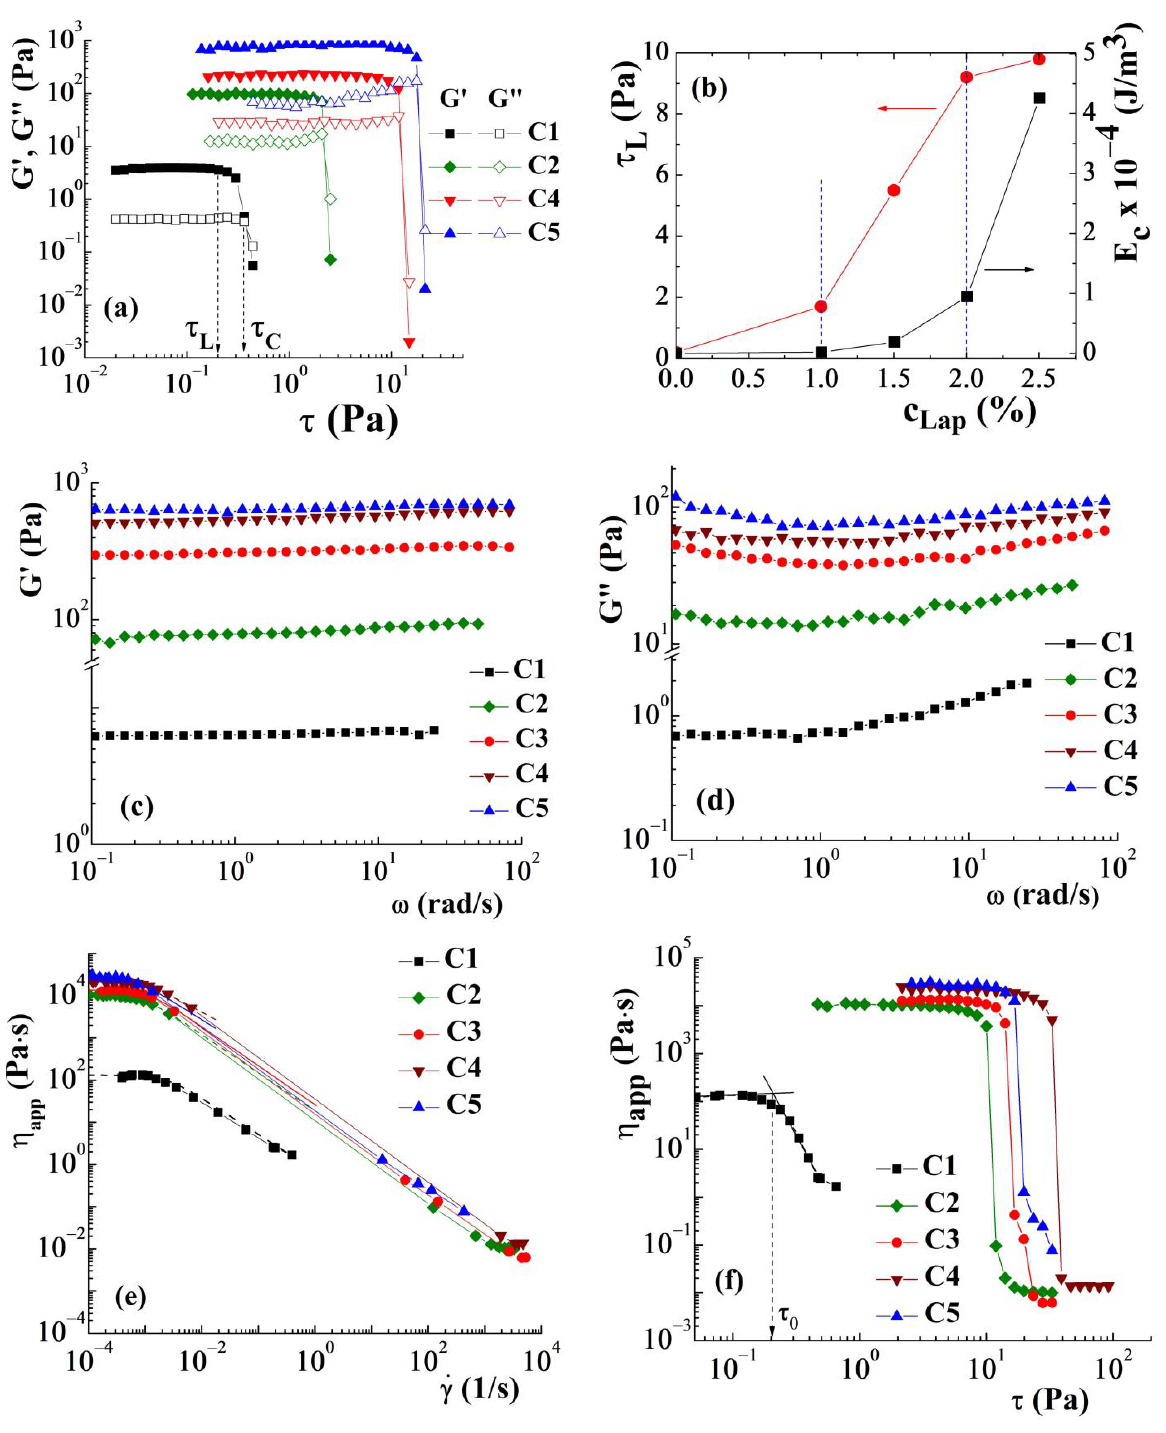
Figure 1. Effect of Lap addition on the rheological behavior of CS/PEG/Lap aqueous dispersions: ( a ) the viscoelastic moduli, G’ and G”, vs. shear stress, τ, at 1 rad/s and 37 °C; ( b ) variation of τ L and E c as a function of clay concentration, c Lap ; ( c ) the storage modulus, G’ and ( d ) the loss modulus, G” vs. oscillatio n frequency, ω at 37 °C; the apparent viscosity, η app , vs. ( e ) shear rate, γ̇ (the full lines rep- resent the fits of experimental data with the three-parameter Carreau equation) and ( f ) shear stress, τ. Table 2. Rheological and swelling parameters of CS/PEG/Lap dispersions and films, respectively.